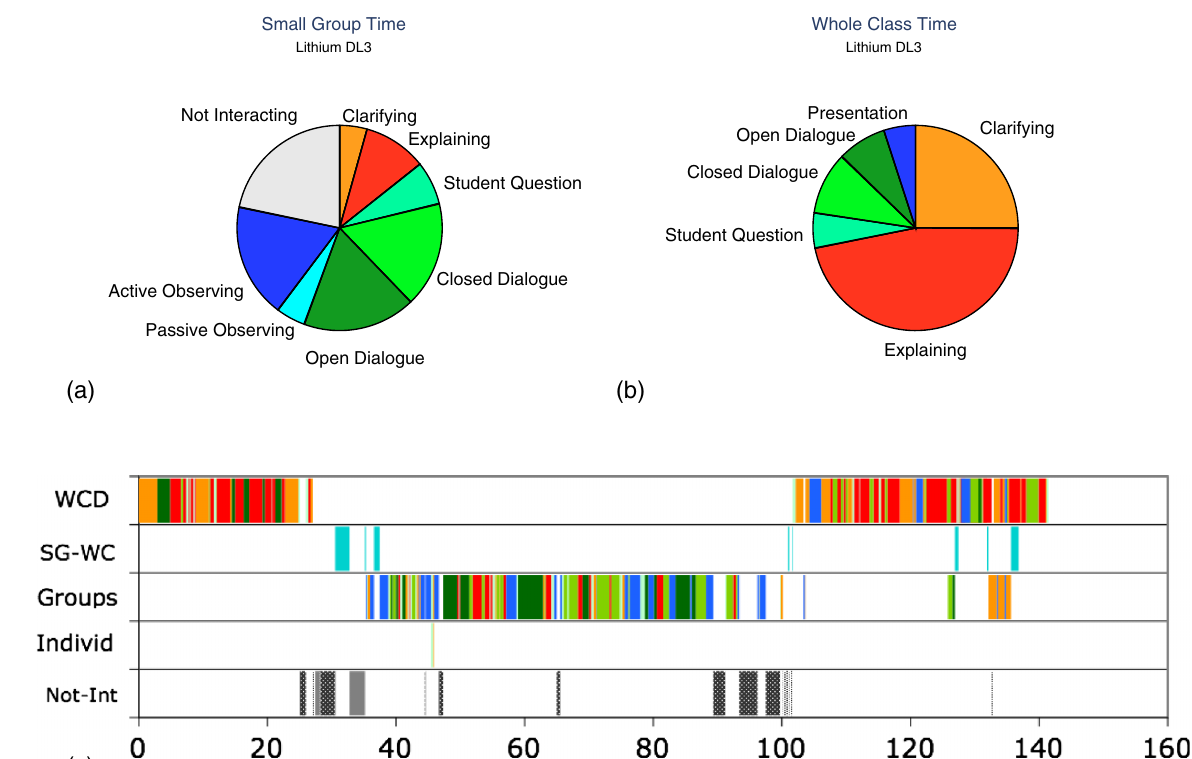
FIG. 2 (color online). Instructor Lithium DL 3. Small group time breakdown (a), whole class breakdown (b), and the time series data (c). The SG-WC line refers to time when the instructor is addressing the whole class during small group time. By definition,